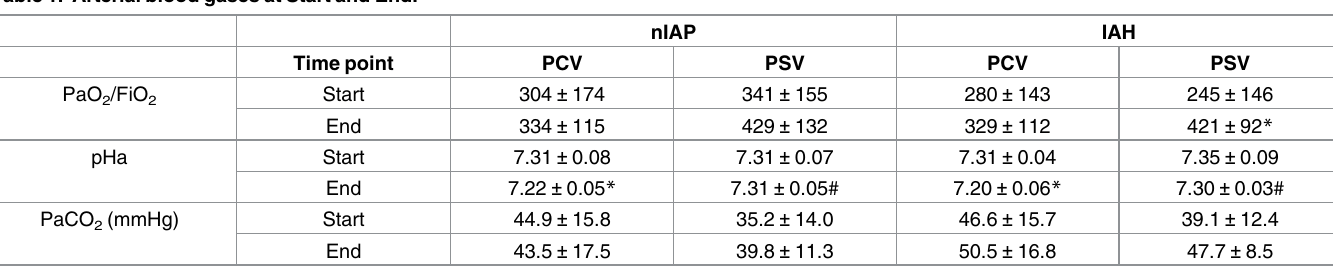
Table 1. Arterial blood gases at Start and End.